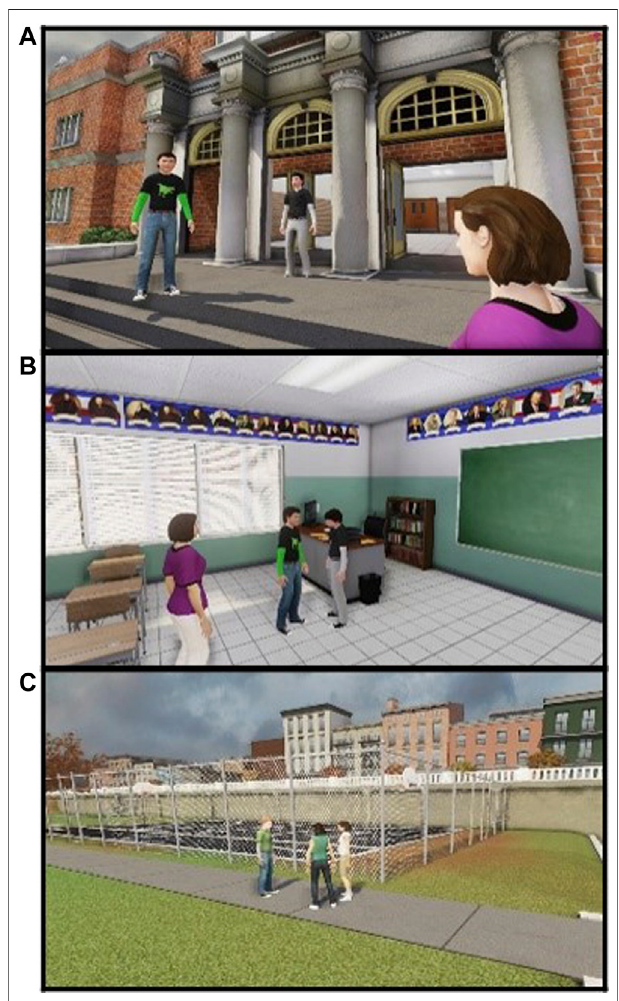
FIGURE 1 | Virtual locations (A) Outside school; Participant, Faux Peer, Coach (B) School classroom; Participant, Faux Peer, Coach (C) Playground and Basketball Courts; Participant, two Faux